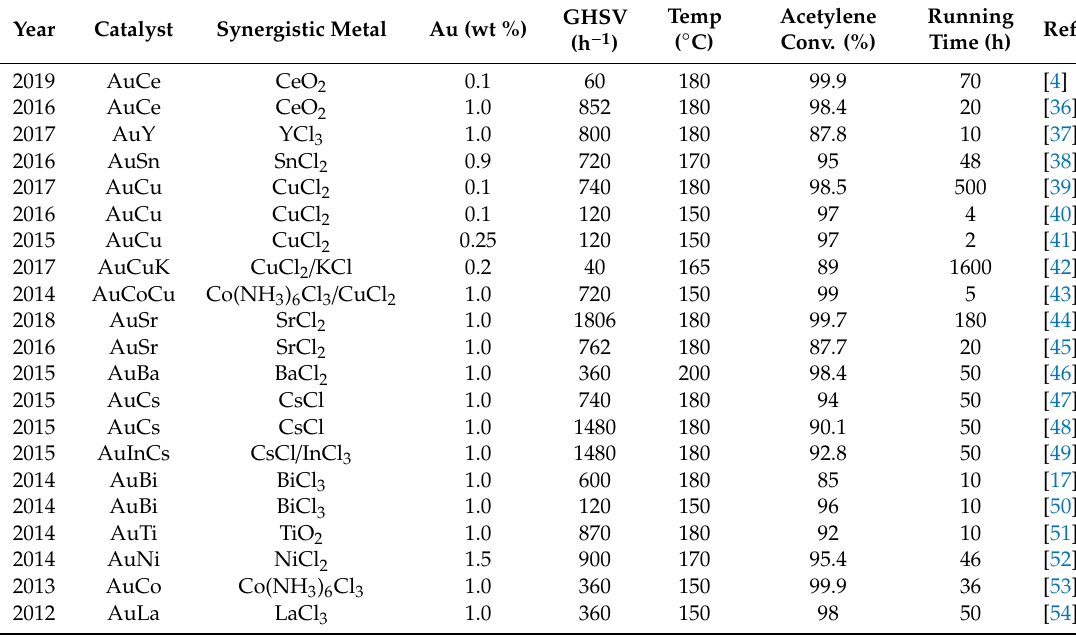
Table 1. Performance of AuM catalysts for acetylene